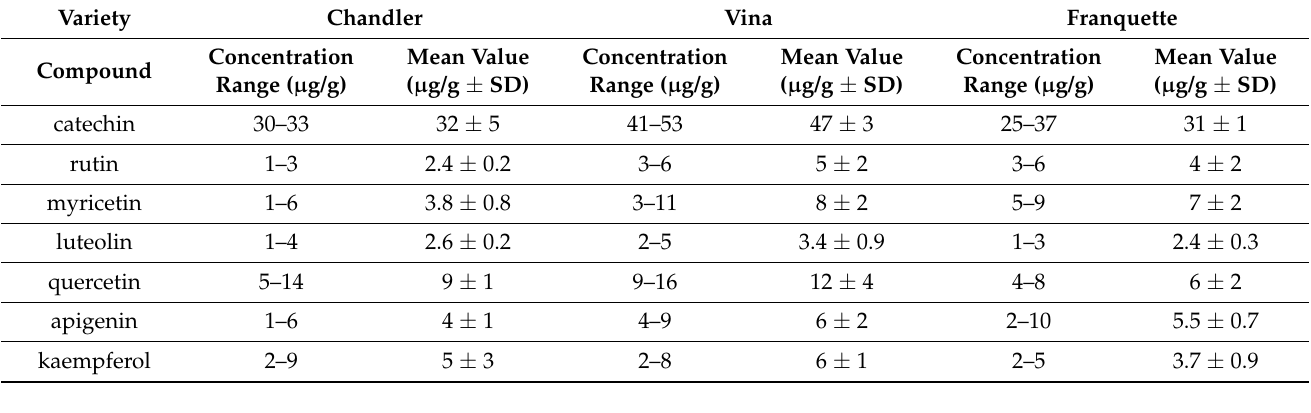
Table 5. Quantification results of the flavonoids determined in walnuts septa belong to Chandler, Vina, and Franquette varieties (samples analyzed in triplicate, n = 3).